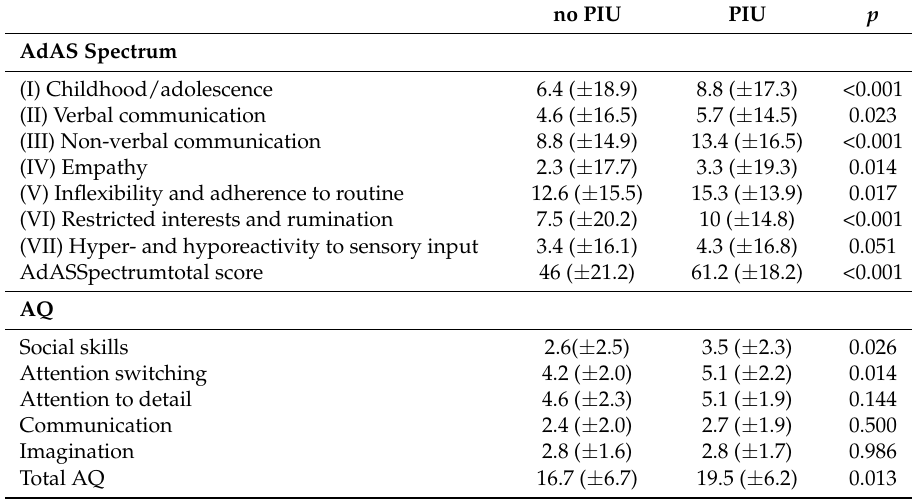
Table 1. Adult Autism Subthreshold Spectrum (AdAS Spectrum) and Autism Quotient questionnaire (AQ) scores in superior university students with putative problematic Internet use (PIU) ( n = 49) with respect to those without ( n =